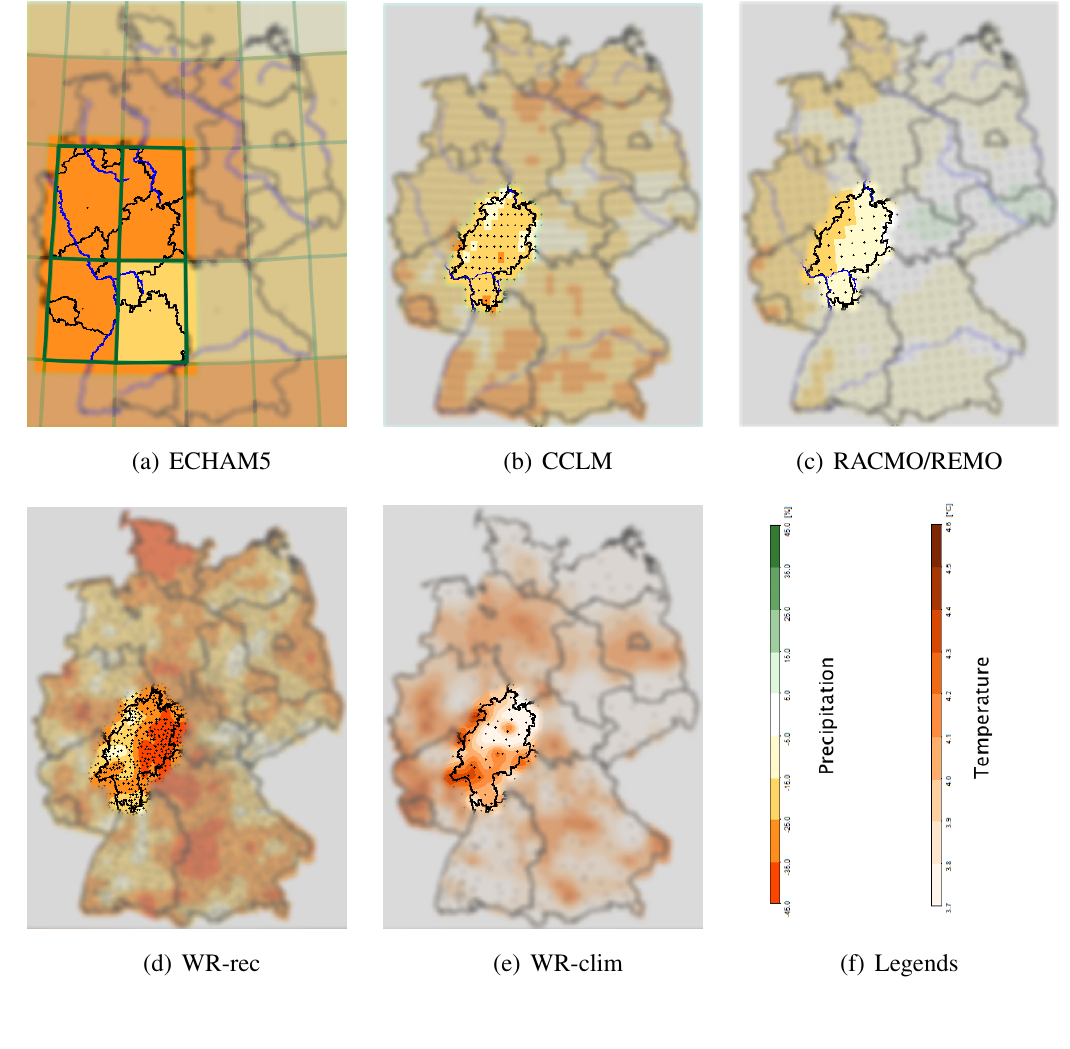
Figure 1. Illustration of the different models’ resolutions. Subfigures ( a )–( d ) display the summer precipitation signal in 1971–2000 (20C) and 2071–2100 (scenario A1B). Subfigure ( e ) displays the respective signal of the daily mean temperature. The grid cells evaluated for ECHAM5 are highlighted in ( a ) and the shape of State of Hesse is indicated by the in-focus area in ( b )–( e ). The left-hand legend in ( f ) corresponds to Subfigures ( a )–( d ) and the right-hand legend in ( f ) is associated with ( e ). Gridpoints and stations are indicated by black